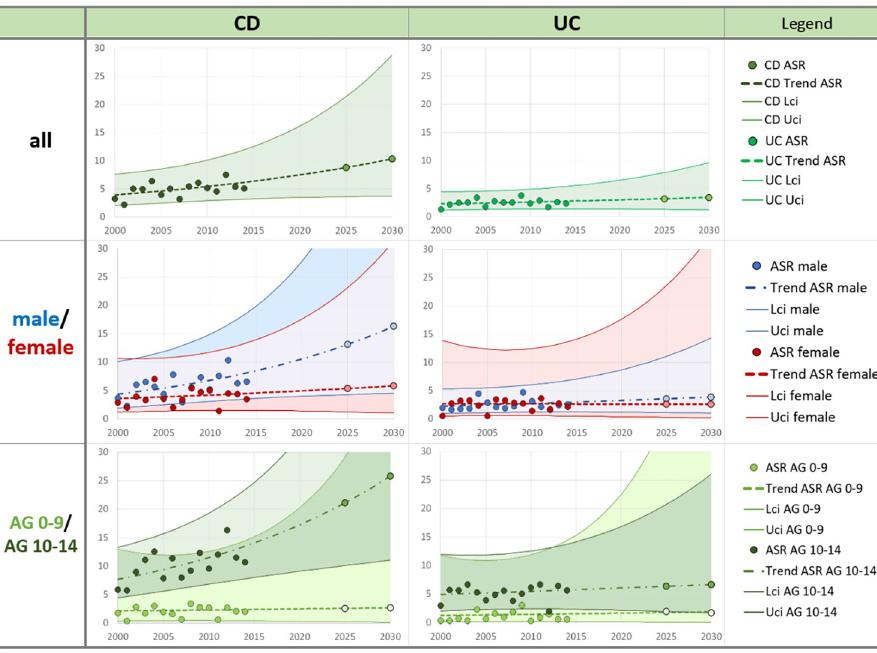
Fig 2. Trends of age-standardized incidence rates (ASR) with projection to 2025, 2030 in Saxony, Germany for Crohn‘s disease (CD) and Ulcerative colitis (UC) by sex and age-groups. Points are observed age-standardized incidence rates (ASR), sex-specific rates and age-specific incidence rates in age groups (AG) per 100,000 PY. Dashed line types are incidence trends of ASR by joinpoint regression with projected points (lighter color) in 2025 and 2030. Corresponding 95% credibility intervals [lower limit (Lci)–upper limit (Uci)] are